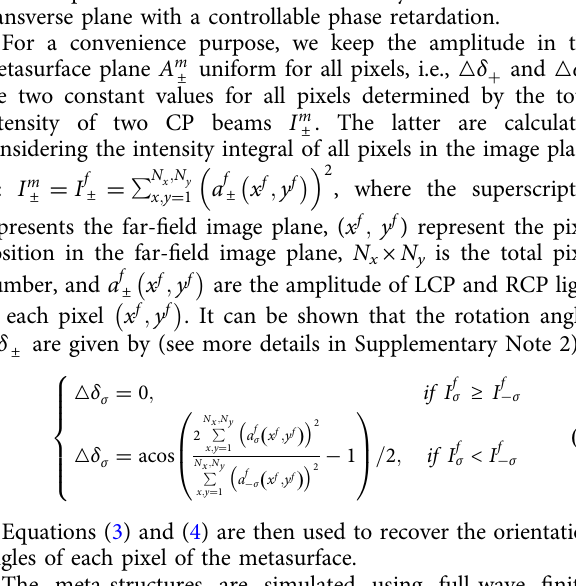
Fig. 1 Design principle of vectorial Fourier metasurface for arbitrary far- fi eld light distribution of intensity and polarization. a Top view of one pixel of the metasurface. Arbitrary polarization requires superposition of two orthogonal polarizations (chosen here as RCP and LCP) with controllable relative amplitudes and phases. To do so, each CP state is produced by two lines of the same handiness with different SOA of 4 δ and δ to control the relative phase. b Perspective view of the metasurface and far- fi eld light distribution. The LP input light can be decomposed into two ± CP beams, which are de fl ected to the same angle of θ t . The holographic phase information is encoded in the LCP and RCP independently, so that arbitrary polarization is realized by the superposition of the two CP beams. c Schematic of the intensity and polarization decoupling using vectorial Fourier metasurface. The orientation angle and ellipticity of the polarization exhibiting a “ Blade ” and a “ Rocket ” images are encoded in a uniformly distributed intensity pro fi